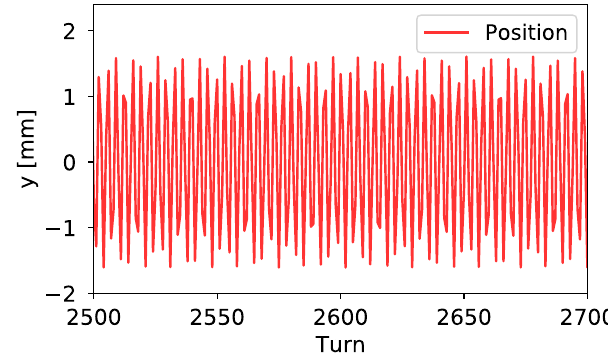
FIG. 2. A close-up plot of the first 200 turns of the flattop excitation showing the coherent turn-by-turn oscillation with an amplitude of A ¼ 1 . 6 mm.